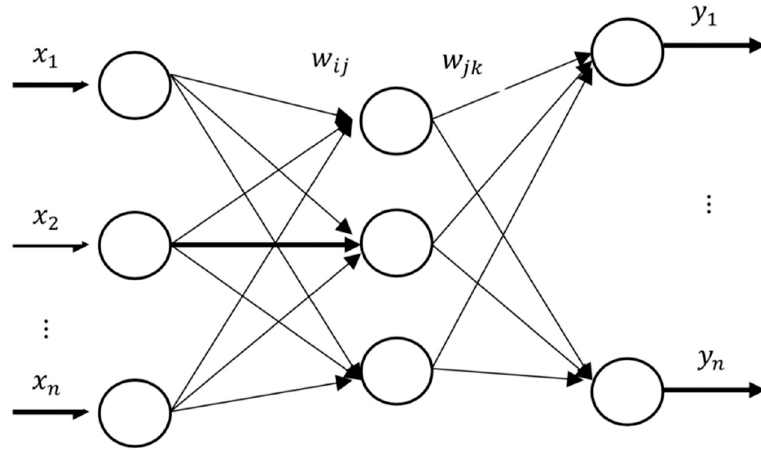
Figure 1. Topology of Neural Networks.